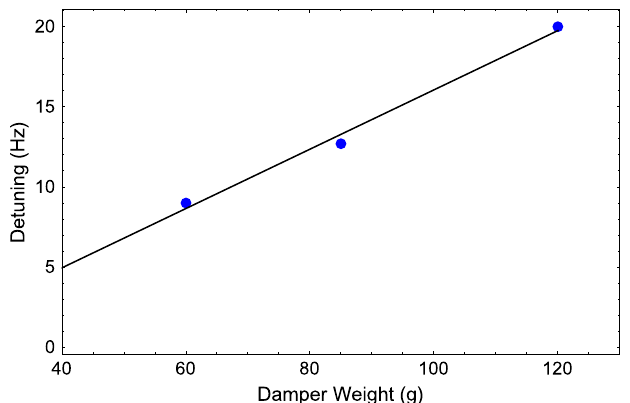
FIG. 12. Detuning level in the presence of slip for various damper weights.